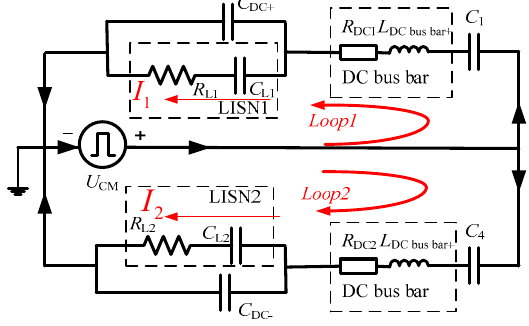
Figure 8. Equivalent circuit of CM interference at 500 KHz.